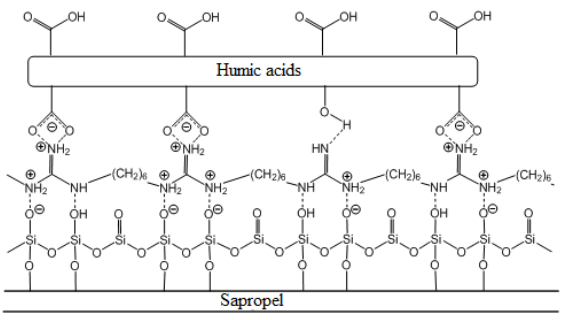
Figure 1: Structural modification of the surface of a mineral part of sapropel with PHMG and pre-isolated